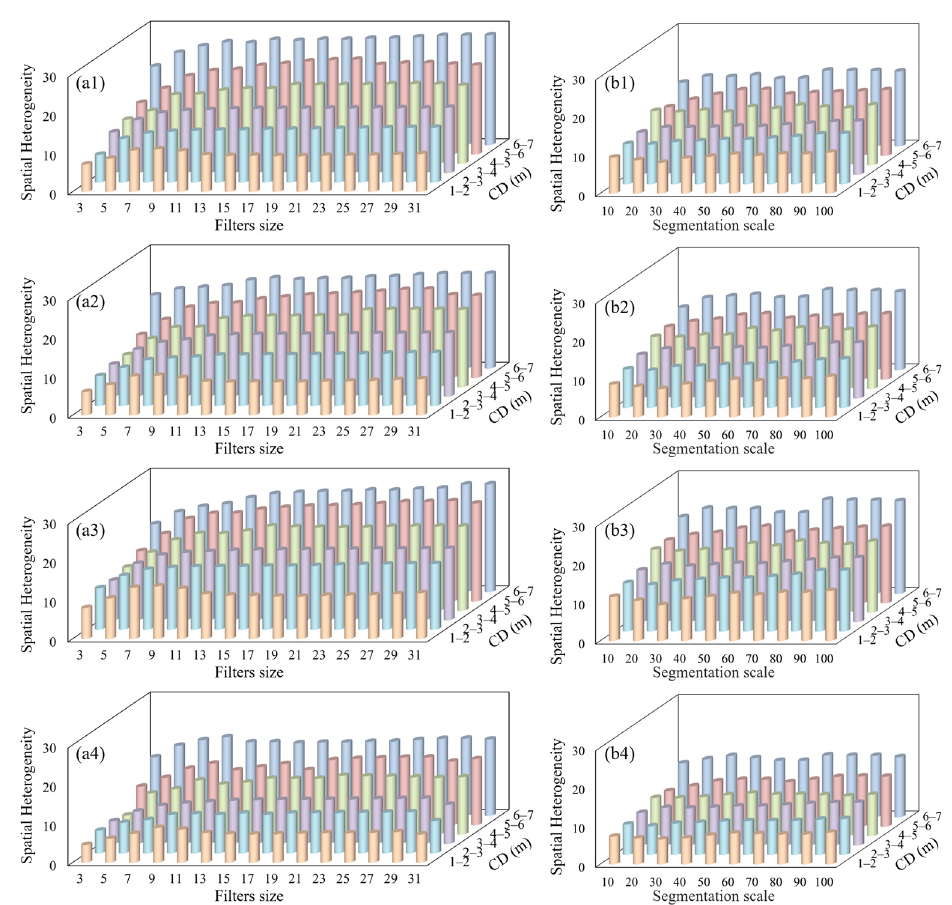
Figure 7. Statistical graphs of SH with different tree CD sizes extracted from GF-2 using two variable extraction methods: ( a1 – a4 ) statistical graphs of SH extracted from band1, band2, band3, and band4 using filter-based method with window sizes ranging from 3 to 31, respectively; ( b1 – b4 ) statistical graphs of SH extracted from blue, green, red, and NIR bands using objected-based methods with segmentation scales ranging from 10 to 100, respectively.